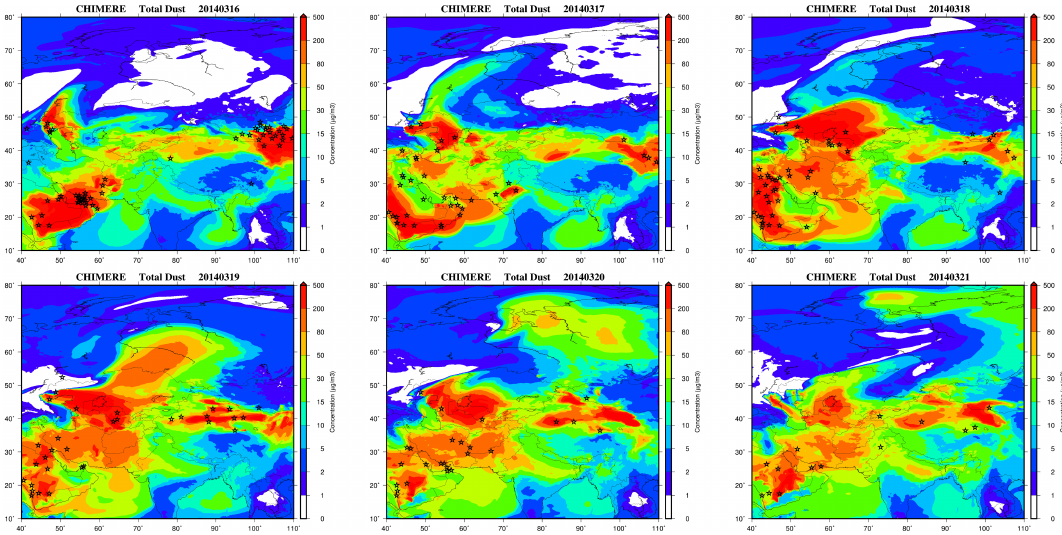
Figure 23. Evolution of daily mean total surface dust concentrations from 16 to 21 March with manned “dust” SYNOP observations at WMO stations (“star” symbol), a symbol is plotted if at least one observation is reported for a given day.